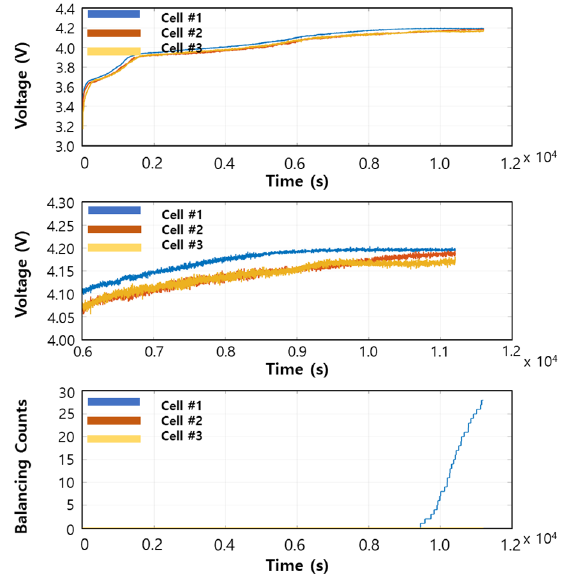
Figure 5. Experimental results from module #1.